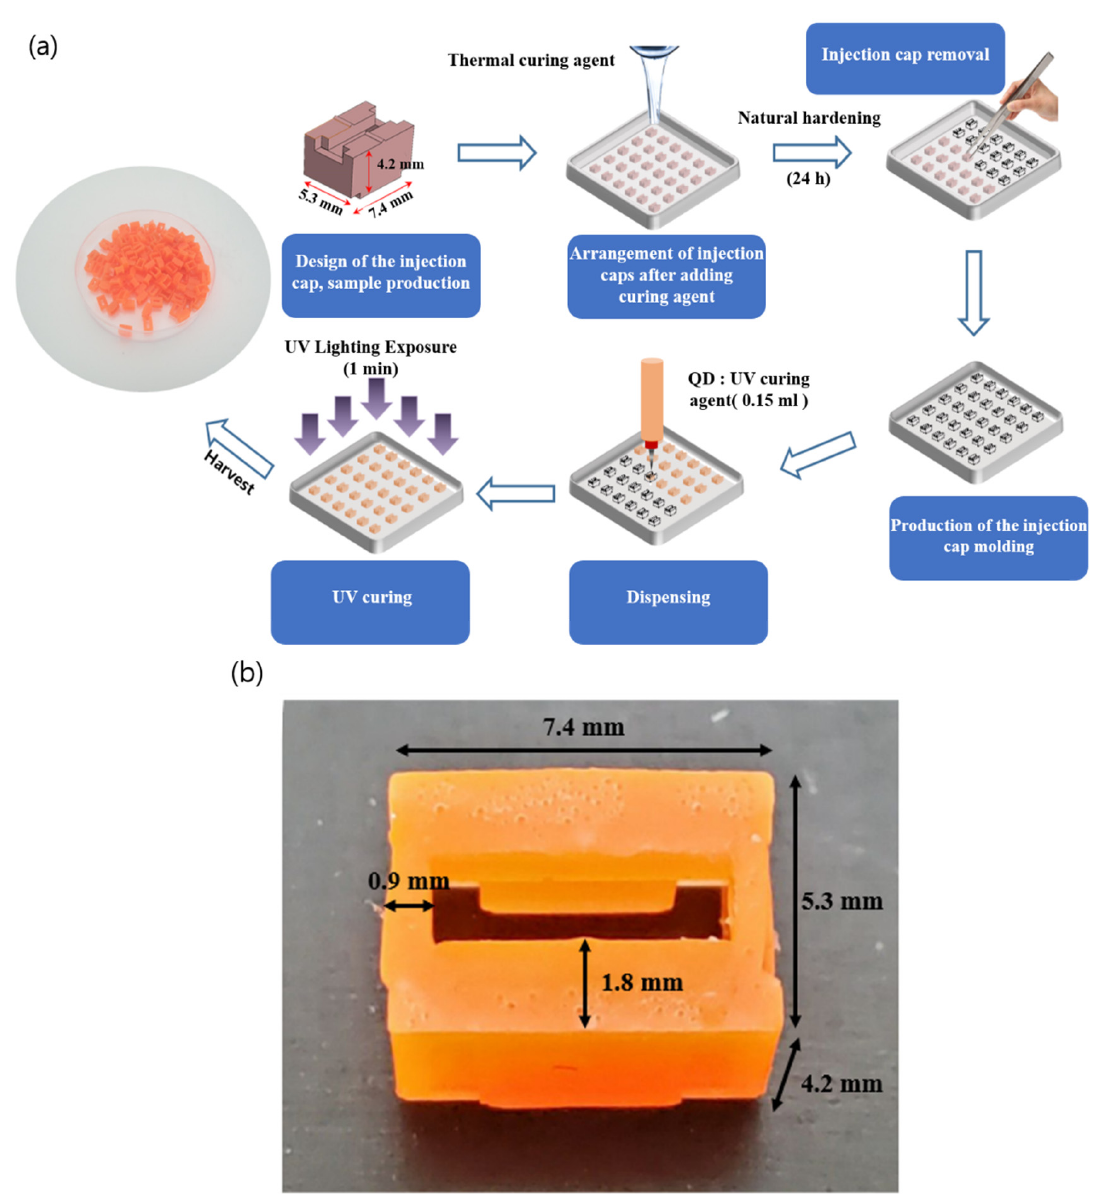
Figure 1. A schematic process of fabrication of red QD caps ( a ) and a picture of the fabricated red QD cap ( b ).